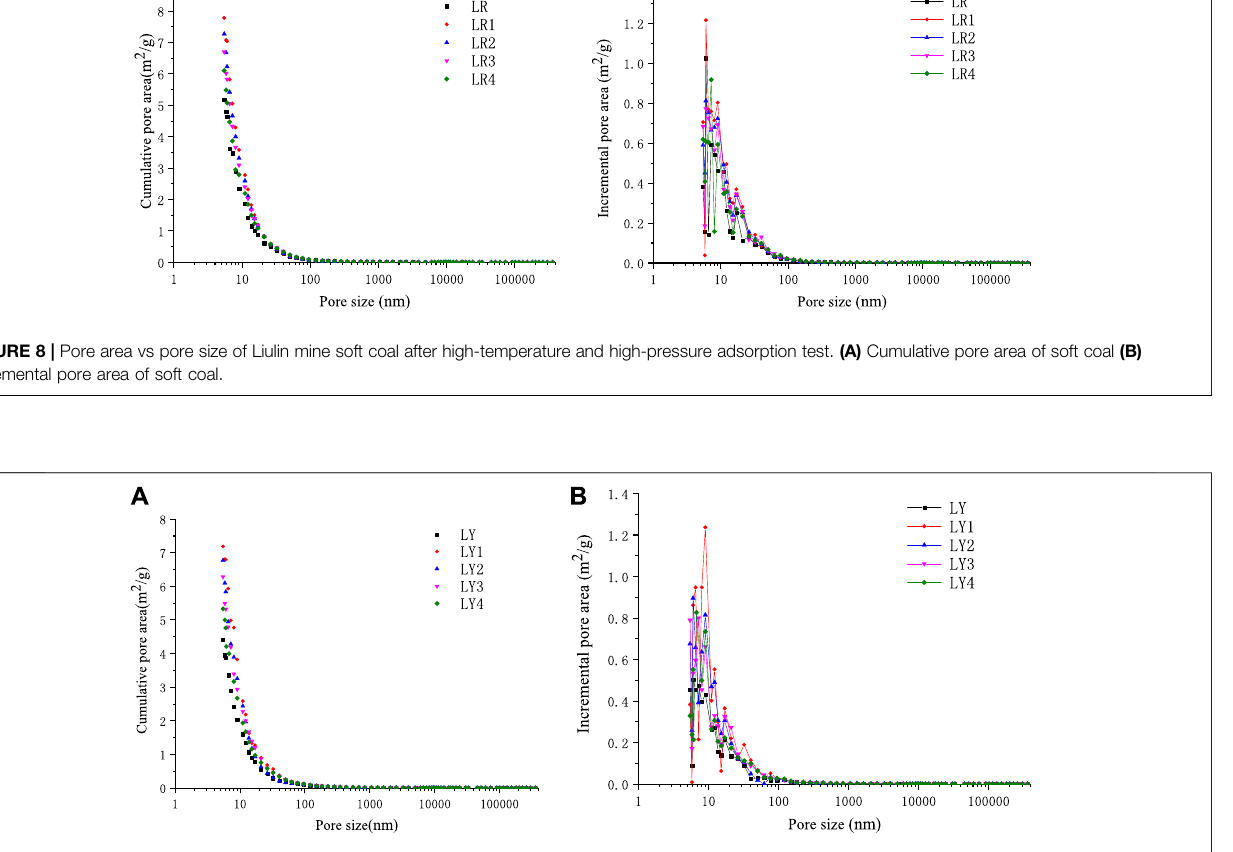
FIGURE 9 | Pore area vs pore size of Liulin mine hard coal after high-temperature and high-pressure adsorption test. (A) Cumulative pore area of hard coal (B) Incremental pore area of hard coal.